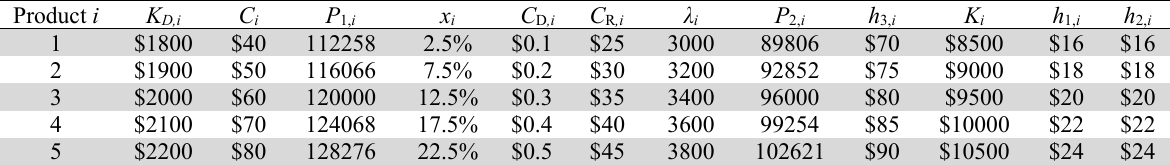
The assumed values of stage two’s relevant variables Product